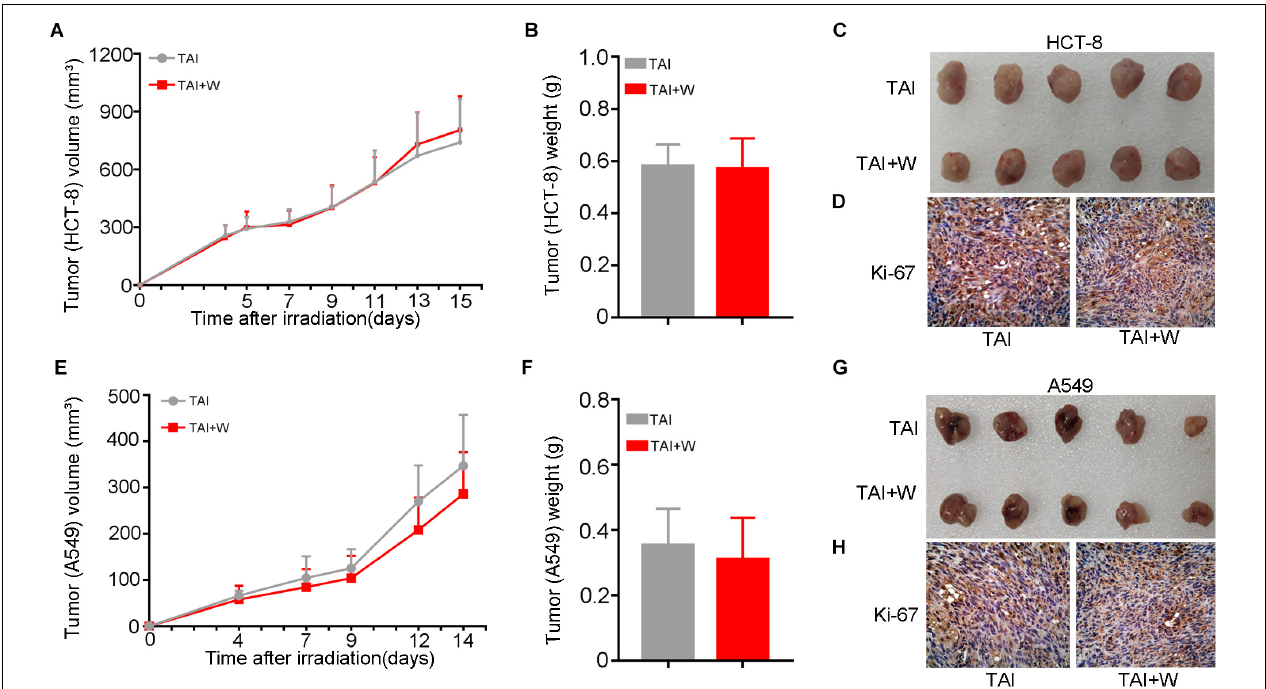
FIGURE 6 | Walking did not alter the proliferation of cancer cells following radiation exposure. We subcutaneously injected HCT-8 or A549 tumor cells into the armpit of nude mice; then the mice received 10 Gy of radiotherapy (2 Gy * 5 days) when the tumors reached 100 mm 3 . The growth of tumors was observed in mice with walking (TAI + W) or not (TAI). The tumor volume was recorded during the tumorigenicity process every 2 or 3 days, n = 8 per group. (A–C) The growth curves of tumors, tumor weights, and representative image of excised tumors of HCT-8 group. (D) The expression levels of Ki-67 in HCT-8 tumor tissues were examined by IHC staining. (E–G) The growth curves of tumors, tumor weights, and representative image of excised tumors of A549 group. (H) The expression levels of Ki-67 in A549 tumor tissues were examined by IHC staining. GI, gastrointestinal; Con, control; TAI, total abdominal irradiation; W, walking; PAS, periodic acid–Schiff; IHC, immunohistochemical.